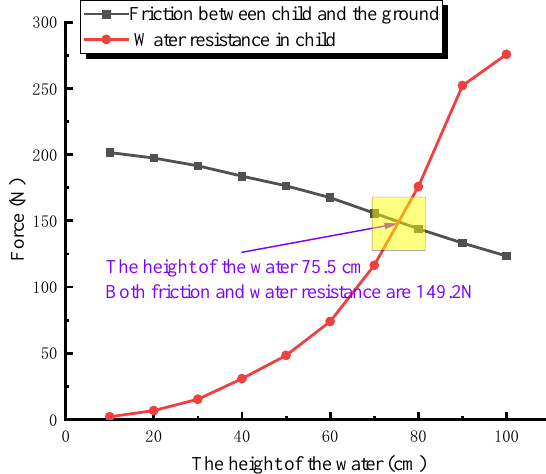
Figure 22. Curve comparison of the flood resistance and friction (adult).